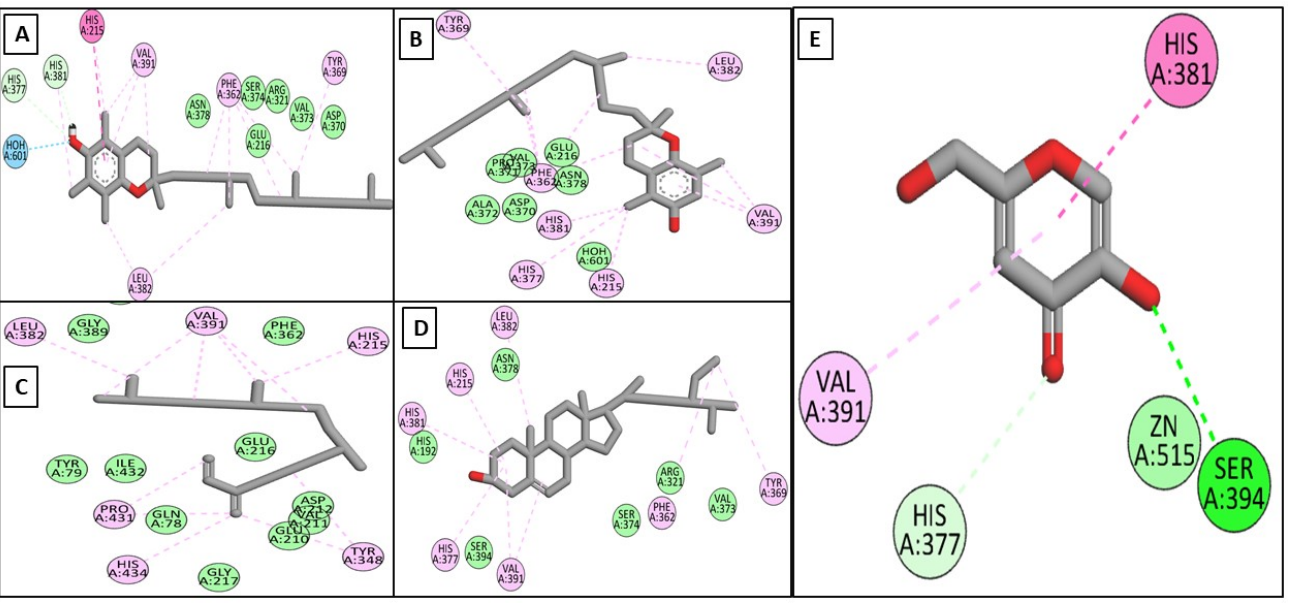
Figure 7. 2D binding modes of α -tocopherol ( A ), β -tocopherol ( B ), neophytadiene ( C ), γ -sitosterol ( D ), and kojic acid ( E ) to the active binding sites of tyrosinase.